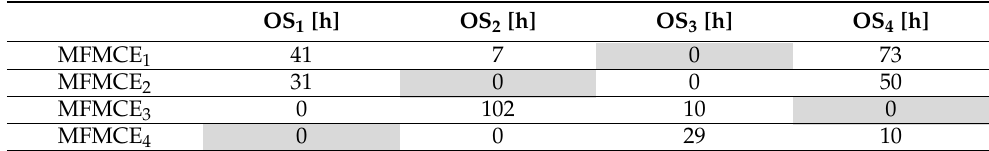
Table 8. Cross combination optimal assignment.